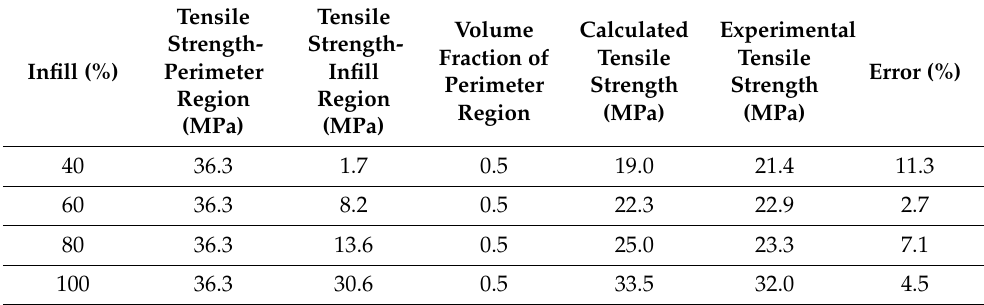
Figure 12. Infill density of 80% at longitudinal orientation: ( a ) equivalent von-Mises stress—infill region; ( b ) equivalent elastic strain—infill region; ( c ) 1st failure index—infill region; ( d ) equivalent von-Mises stress—perimeter region; ( e ) equivalent elastic strain—perimeter region; and ( f ) 1st failure index—perimeter region. Table 9. Modelling results for the infill density set—longitudinal orientation (Method 2).